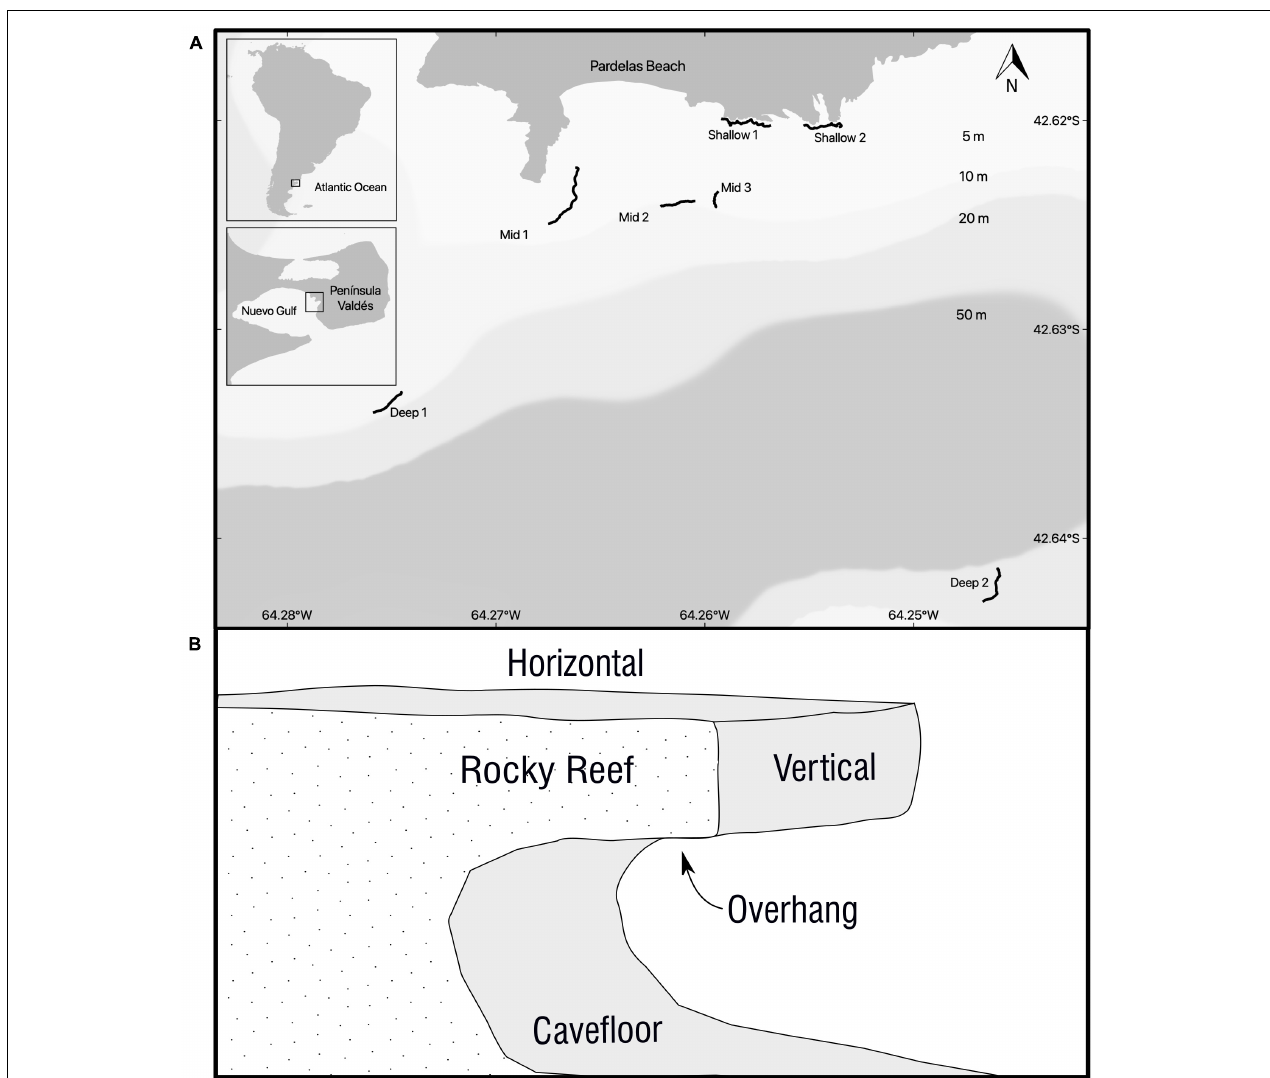
FIGURE 1 | (A) Study site, location and extension of all the rocky reefs sampled. Black lines are the GPS track of the rocky reefs ledges. (B) Diagram of a transversal view of a typical Patagonian rocky reefs where surface orientations (horizontal, vertical, overhang, and cavefloor) are